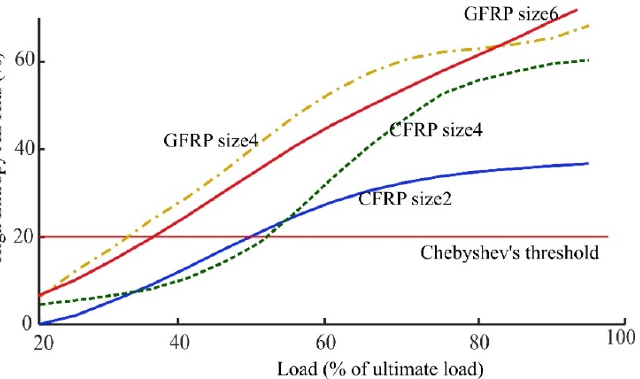
Figure 8. Evolution of the number of AE hit with high entropy using Fourier transform in different percent of ultimate load for different FRP rods.